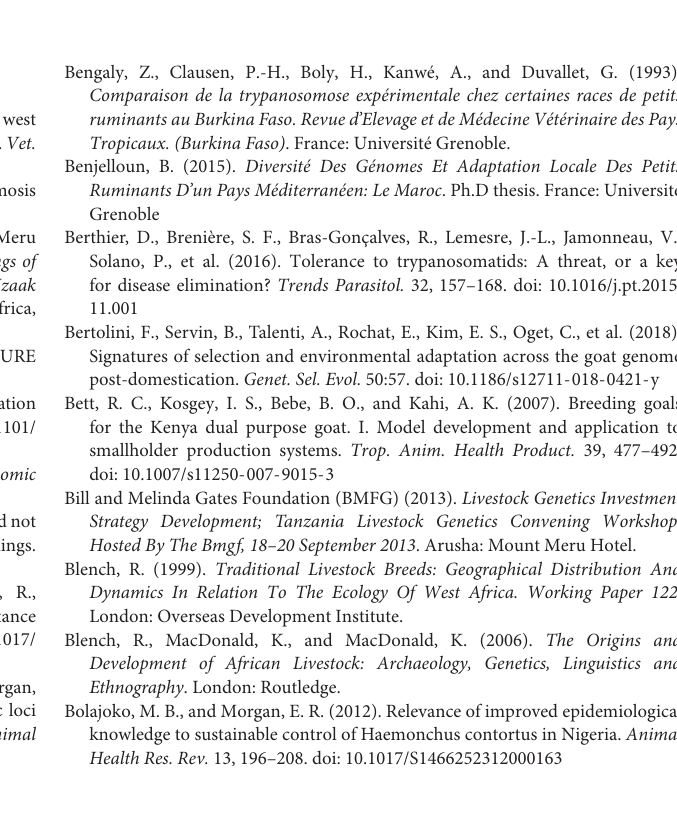
according to LFMM following the climatic PCA/HCPC ranking.